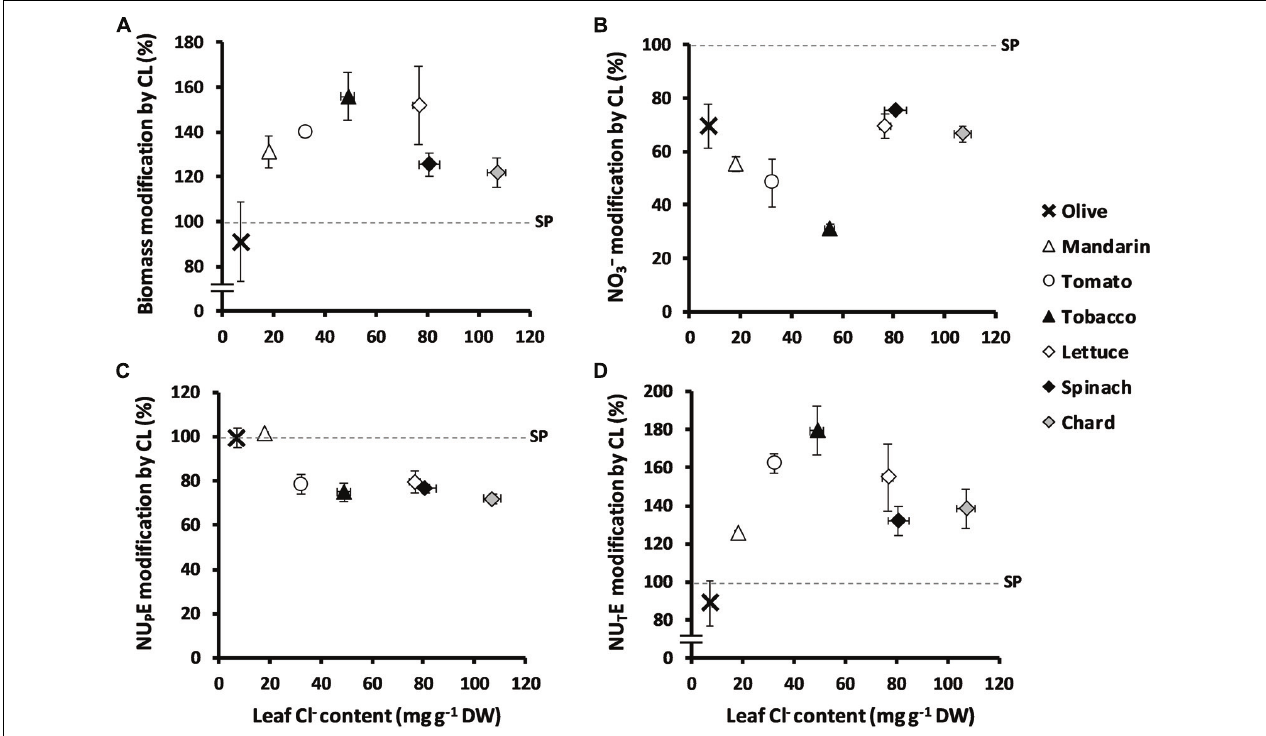
FIGURE 4 | Effect of Cl − nutrition on plant growth, NO 3 − content, N uptake efficiency (NU P E), and N utilization efficiency (NU T E) in several species of agronomic interest. Plants were treated with two nutritional treatments: 5 mM Cl − salts (CL) and a mixture of SO 42 − + PO 43 − salts (SP) containing the same cationic balance as in the CL treatment. Ratios of total biomass (A) , NO 3 − content expressed as mg kg − 1 of fresh weight (B) , NU P E (C) , and NU T E (D) are presented considering the % of CL in relation to SP treatment and in contrast to leaf anion content in several species. Olive ( Olea europaea L. ssp. europaea ; bold cross), mandarin ( Citrus reshni Hort. ex Tan; open triangles), tomato ( Solanum lycopersicum L.; open circles), tobacco ( Nicotiana tabacum L.; filled triangles), lettuce ( Lactuca sativa L.; open diamonds); spinach ( Spinacia oleracea L.; filled diamonds), and chard ( Beta vulgaris L. ssp. vulgaris ; gray-colored diamonds); mean values ± SE, n =